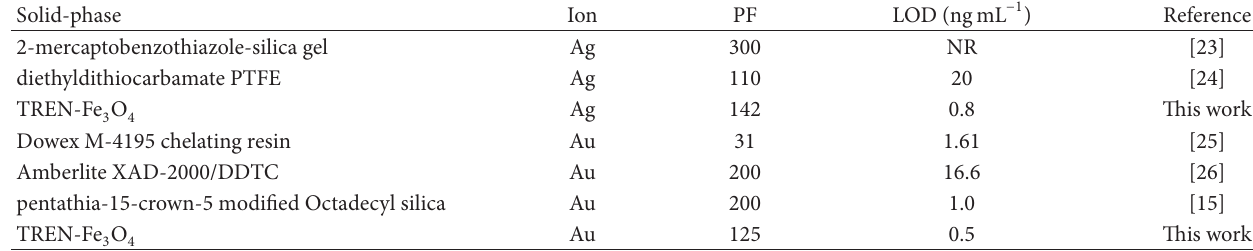
T 6: Data of real sample analysis for Ag and Au on TREN-Fe